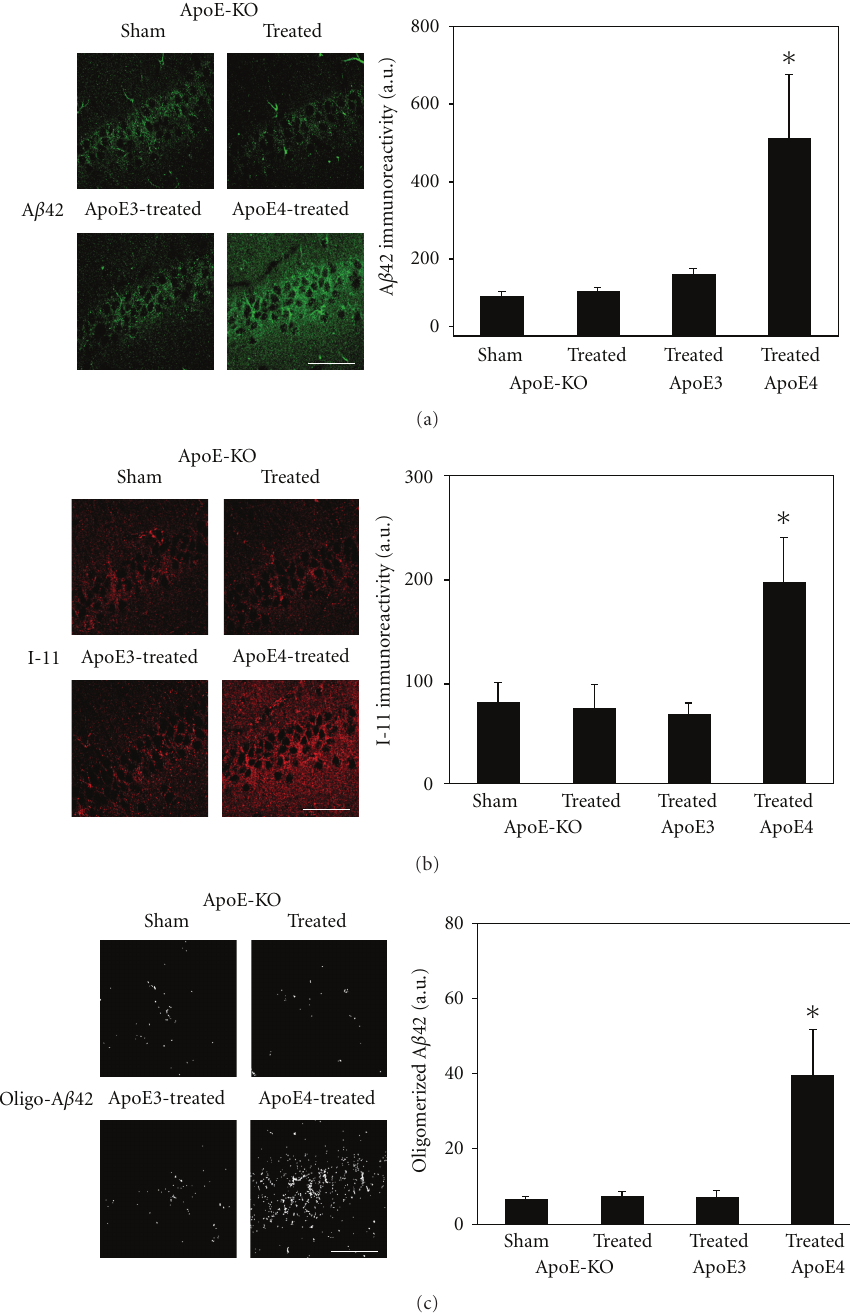
Figure 1: The e ff ects of apoE3, apoE4, and apoE deficiency on the levels of A β 42 and oligomerized A β 42 in CA1 hippocampal neurons following inhibition of neprilysin. ApoE3, apoE4, and apoE-deficient male mice were injected i.c.v. with the neprilysin inhibitor thiorphan or sham-treated for 7 days, after which their brains were excised and subjected to anti-A β 42 and anti-I-11 immunofluorescence, as described in “Materials and Methods.” (a) Representative coronal sections of sham- and thiorphan-treated apoE-deficient mice (upper row) and thiorphan-treated apoE3 and apoE4 mice (lower row) immunostained with anti-A β 42 are shown on the left (bar = 50 μ m). Quantification of the density of A β 42 staining (mean ± SEM; n = 5–6mice/group in the sham- and thiorphan-treated groups) in the CA1 neurons of the indicated mice is shown on the right. P < . 05 for the e ff ects of treatment on the three mouse groups by one-way ANOVA. (b) Representative confocal images of I-11 of the CA1 area of the indicated mouse groups treated for 7 days with thiorphan (left) and quantification (right) of the density of I-11 staining (mean ± SEM; n = 5–6mice/group in the sham- and thiorphan-treated groups) (mean ± SEM; n = 4–5). P < . 03 for the e ff ect of treatment on the three mouse groups by one-way ANOVA. (c) Representative masked oligo-A β 42 images of the CA1 area of the indicated mouse groups treated for 7 days with thiorphan (left) and quantification (right) of the density of oligo-A β 42 staining (mean ± SEM; n = 5–6mice/group in the sham- and thiorphan-treated groups). P < . 05 for the e ff ect of treatment on the three mouse groups by one-way